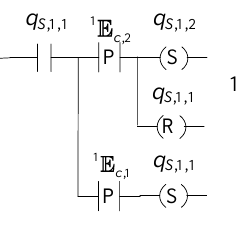
S . Figure 12. State diagram of S 1 . 1